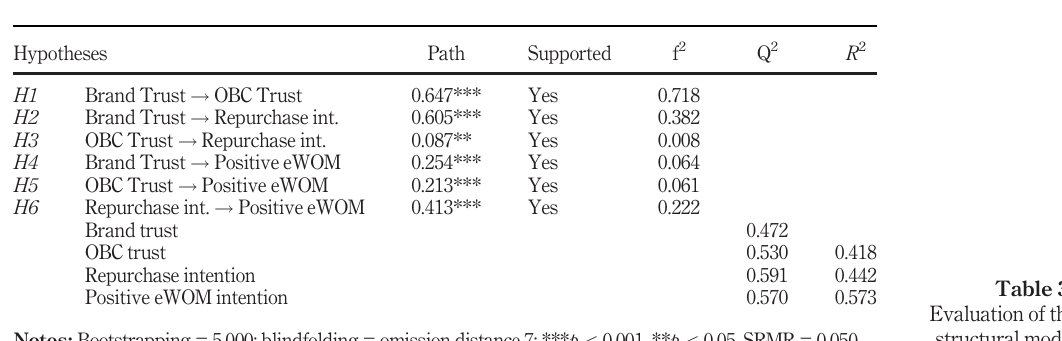
Table 3. Evaluation of